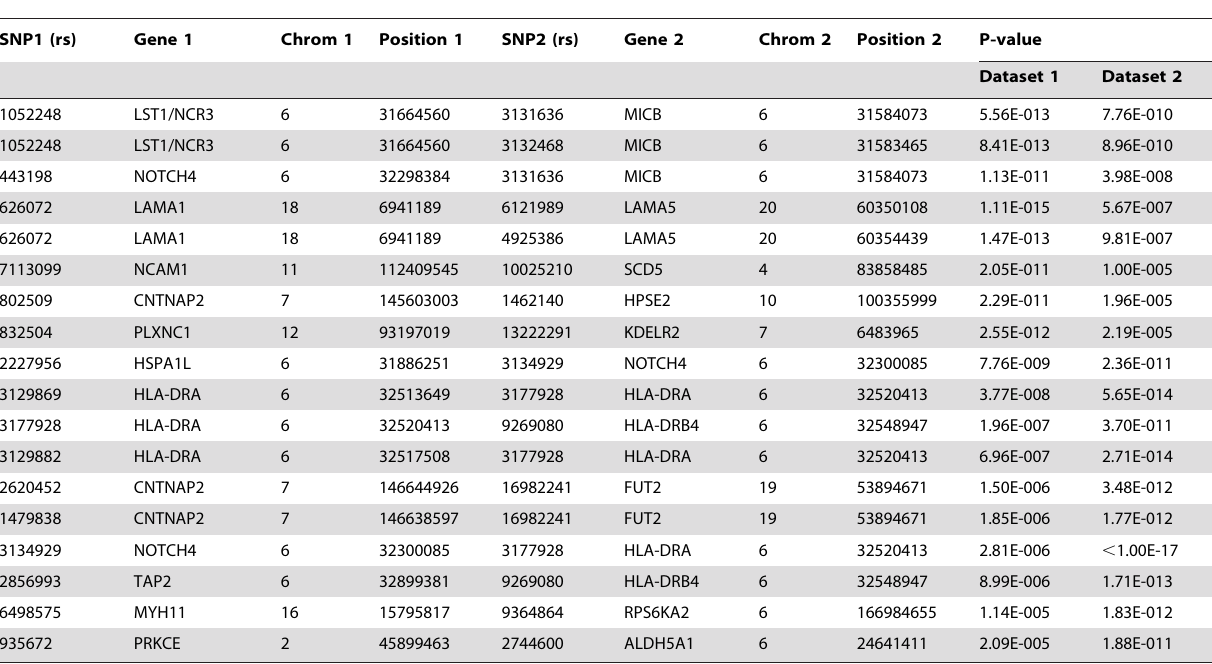
Table 8. A total of 18 significantly interacting SNPs identified by Bonferroni